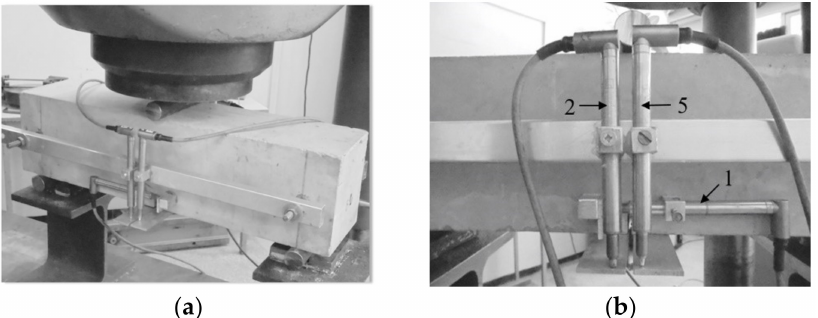
Figure 3. Flexural tensile strength test (f ct,fl ): ( a ) C2 beam; ( b ) location of sensors for measuring deflections (No. 2 and 5) and notch opening (No. 1) in C1